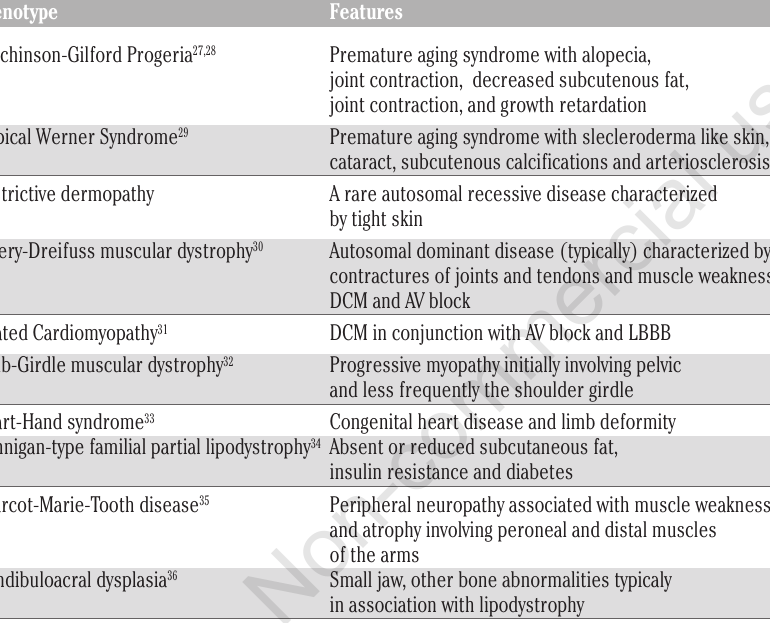
Table 2. Partial list of phenotypes caused by LMNA